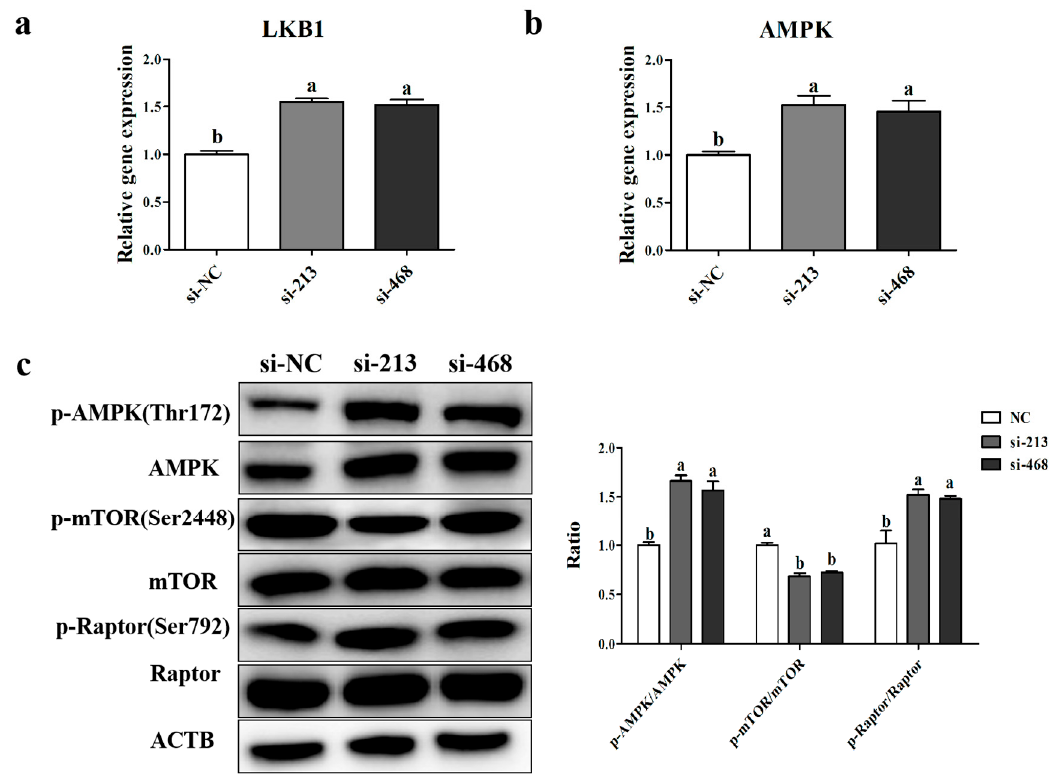
Figure 9. Liver Kinase B1 ( LKB1 ) and AMP-activated protein kinase ( AMPK ) mRNA expression in the transfected myoblasts ( a , b ) was determined using qRT-PCR. AMPK , p-AMPK , mTOR , p-mTOR , Raptor , and p-Raptor protein expression ( c ) was determined using Western blot, and the ratios of these proteins are presented in column ( c ). The expression of genes and proteins was normalized to β -actin ( ACTB ) and related to si-NC as mean values ± SEM ( n = 3). a, b, c: different letters denote statistically significant differences within each group; p < 0.05.